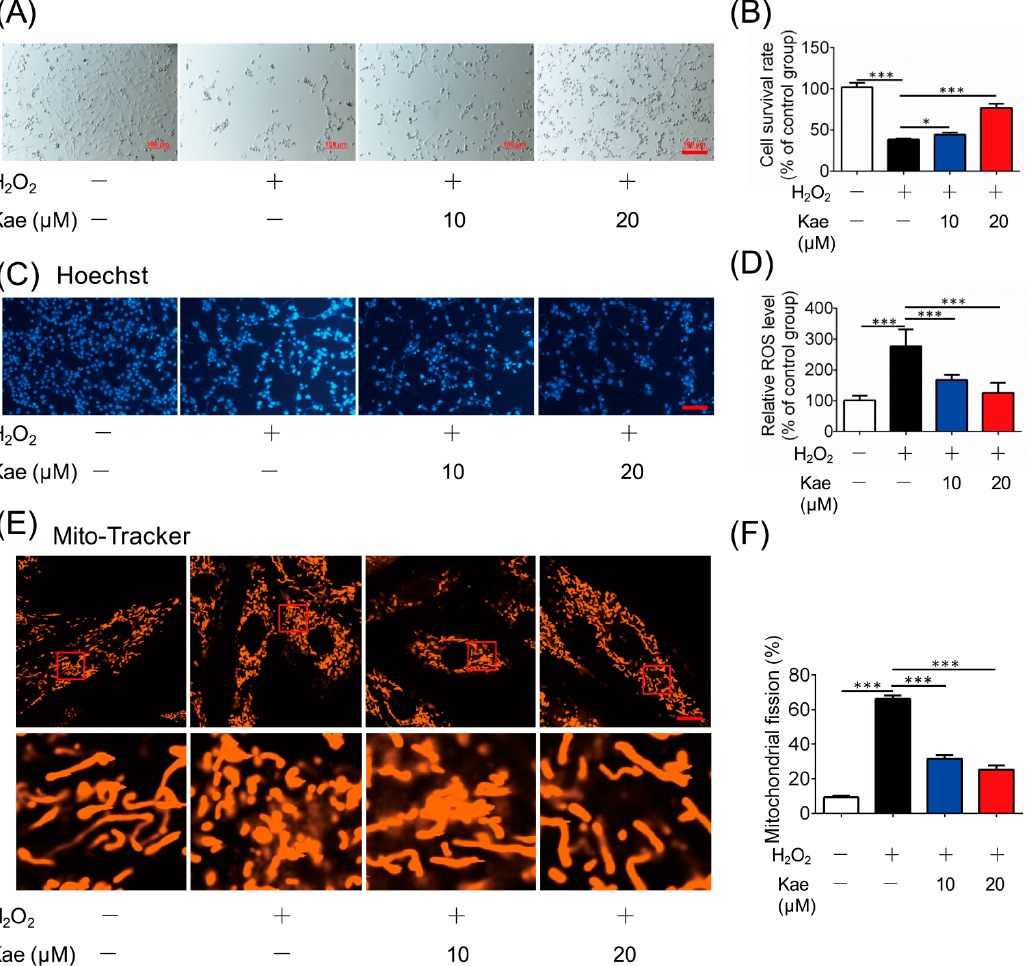
Figure 4. Kae protects cardiomyocytes. ( A ) Cell morphology analysis (scale bar, 100 μ m). ( B ) Cell survival rate analysis ( n = 6). ( C ) Kae-induced nuclear morphological changes were examined by using fluorescence (scale bar, 100 μ m). ( D ) Intracellular ROS production ( n = 6). ( E ) Mitochondrial fission imaging. (Scale bar, 5 μ m). ( F ) Quantification of relative mitochondrial fission ratio ( n = 6). * p < 0.05, *** p < 0.001.